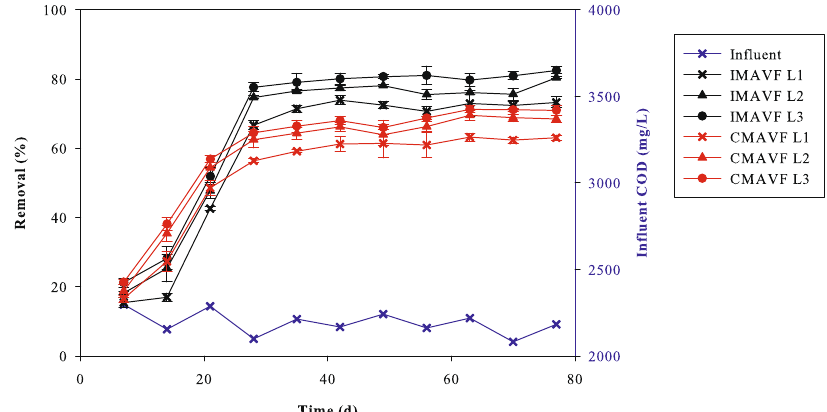
Fig. 1 Effect of intermittent feeding on COD removal. IMAVF Intermittently fed macrophyte assisted vermi fi ltration, CMAVF Continuously fed macrophyte assisted vermi fi ltration; Error bars: standard deviation created using replicated ( n = 3) set-ups for each experimental condition]. Three layers placed at 0 – 30 cm (L3), 30 – 60 cm (L2), and 60 – 100 cm (L1) from the bottom, containing gravel, alum, and soil mix,